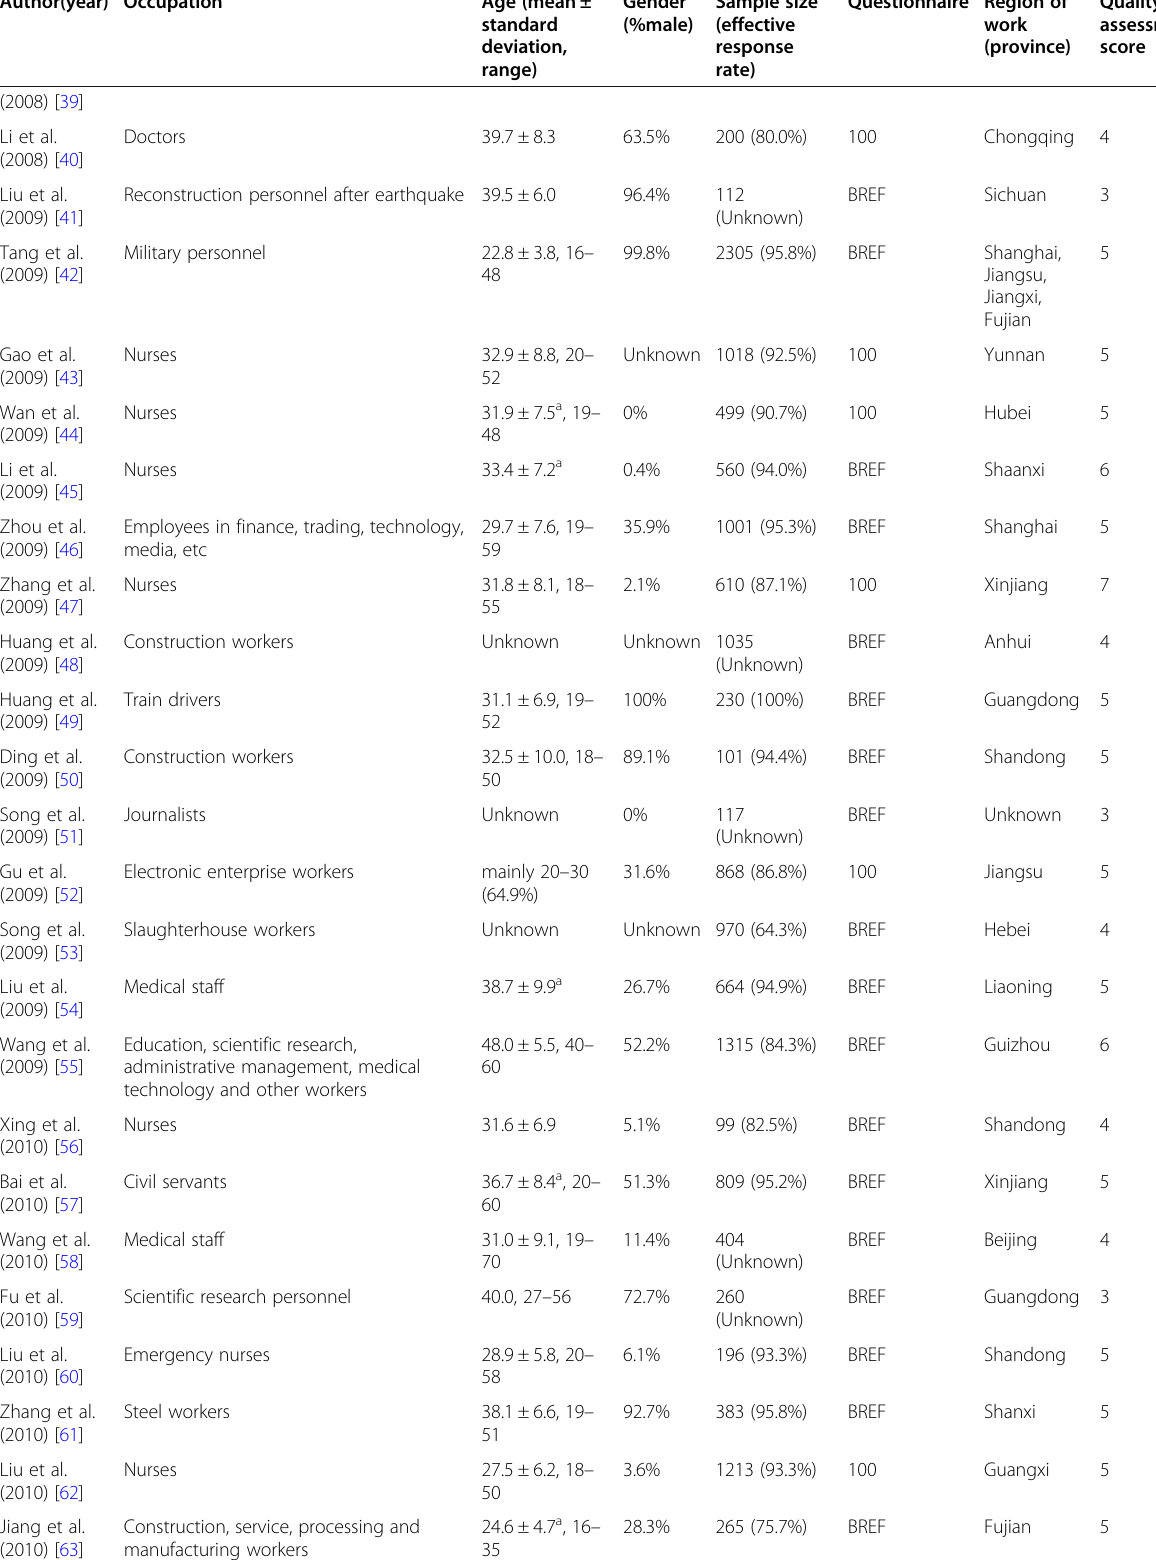
Table 2 Descriptive characteristics and quality assessment of the included publications